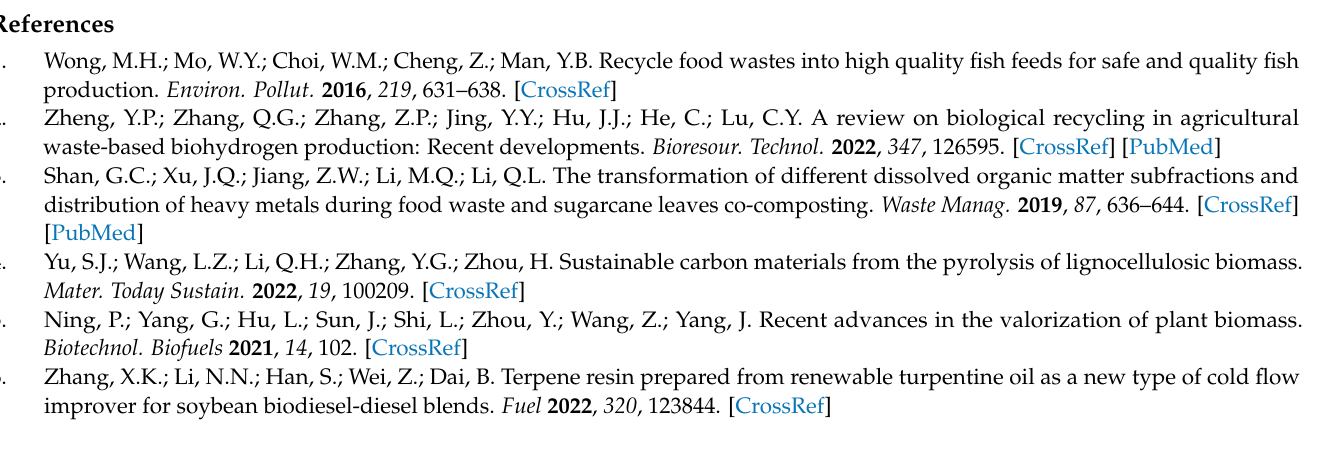
ethanol sample. Table S2: Gas chromatography-mass spectroscopy analysis of the methanol sample. Table S3: Pyrolysis/gas chromatography-mass spectroscopic analysis of A. Bunge